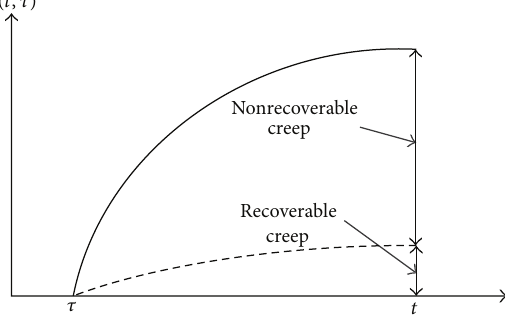
Figure 15: A general description of specific creep.